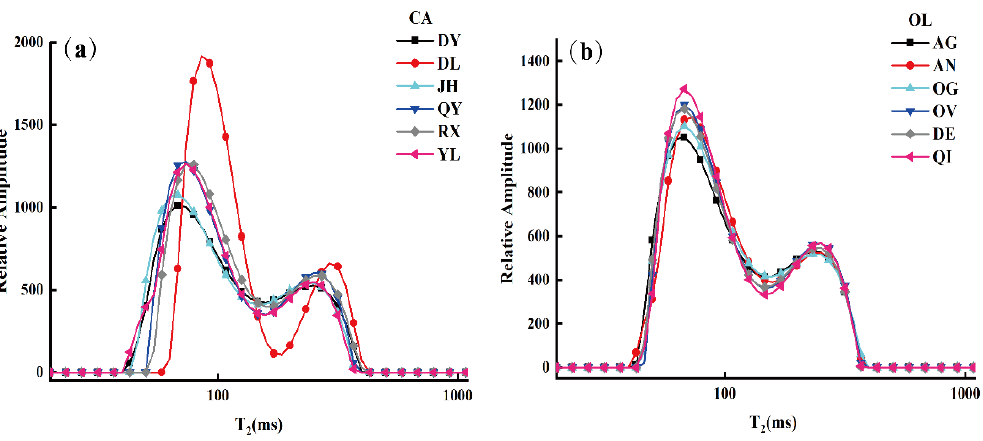
Figure 2. T 2 distribution of different brands of camellia oil (CA) ( a ) and olive oil (OL) ( b ). The transverse relaxation parameters of the samples (i.e., T 2 w , T 21 and T 22 ) and the integral area percentages of different components (i.e., S 21 , S 22 ) are summarized in Table 2